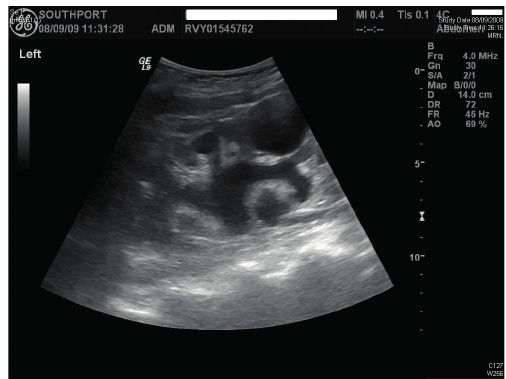
Figure 2: Ultrasound revealed moderate hydronephrosis of left kid- ney.